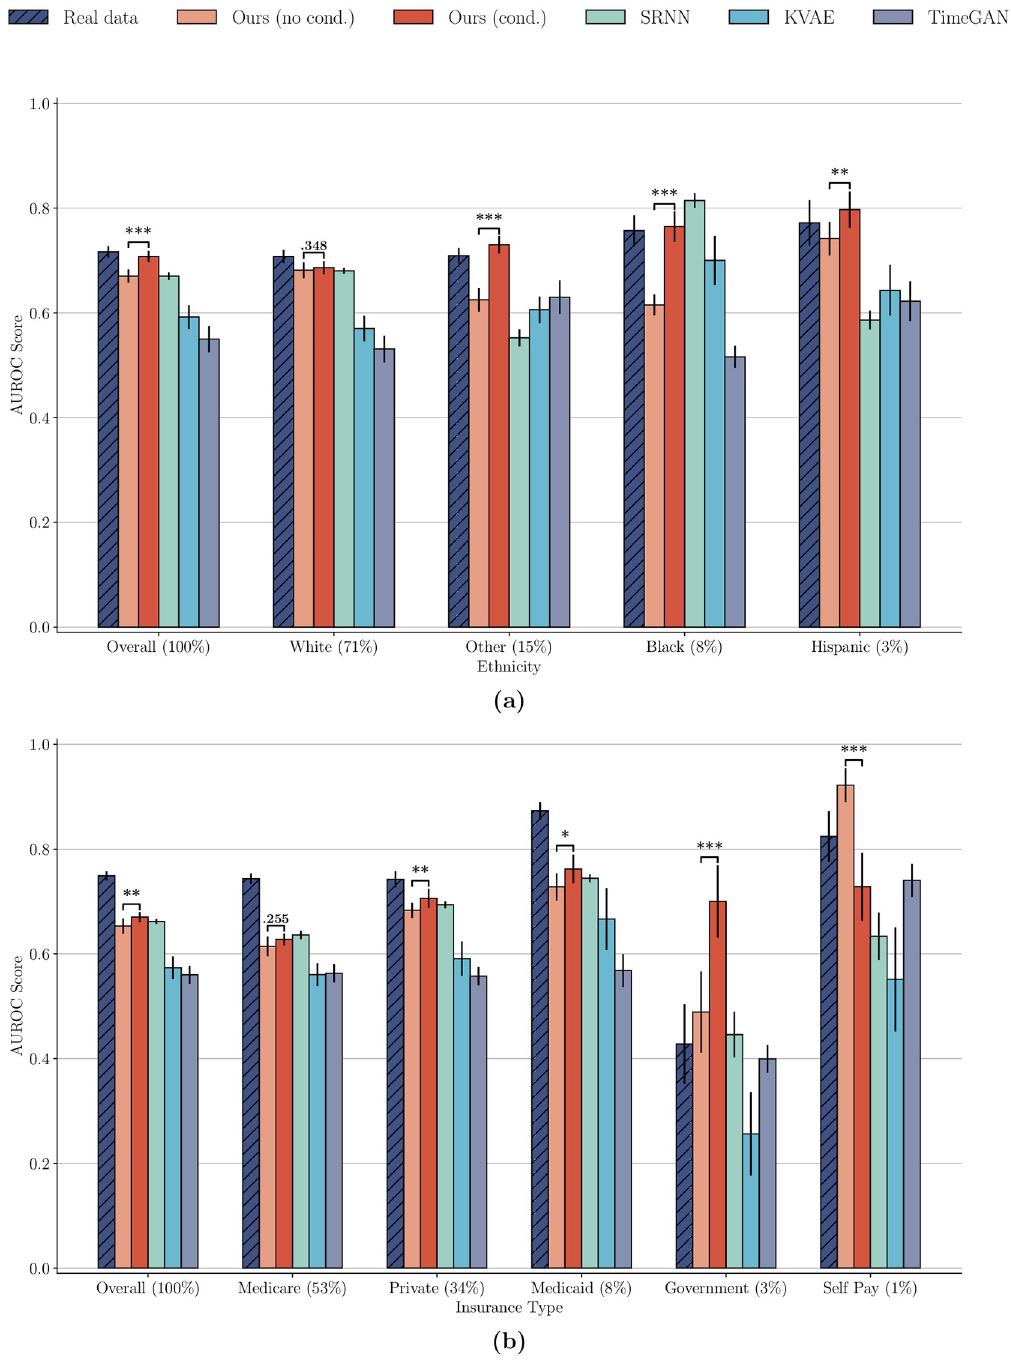
Fig 2. Comparison of AUROC score between our model when conditionally and unconditionally generating synthetic data with baselines. We show results of the colloid_bolus task for different ethnicity groups (a) as wells as the range of insurance types (b). Note that the Asian subpopulation is not among the ethnicity groups, as there are no positive validation samples among this group for the considered task, thereby prohibiting the calculation of the AUROC score. Conditionally generating patient cohorts is favourable to unconditional generation overall, and for almost all subgroups, allowing for the generation of more representative and therefore fair synthetic data sets. Significance levels between groups of interest are shown with brackets, where � corresponds to p < 0.05, �� to p < 0.01 and ��� to p < 0.001.